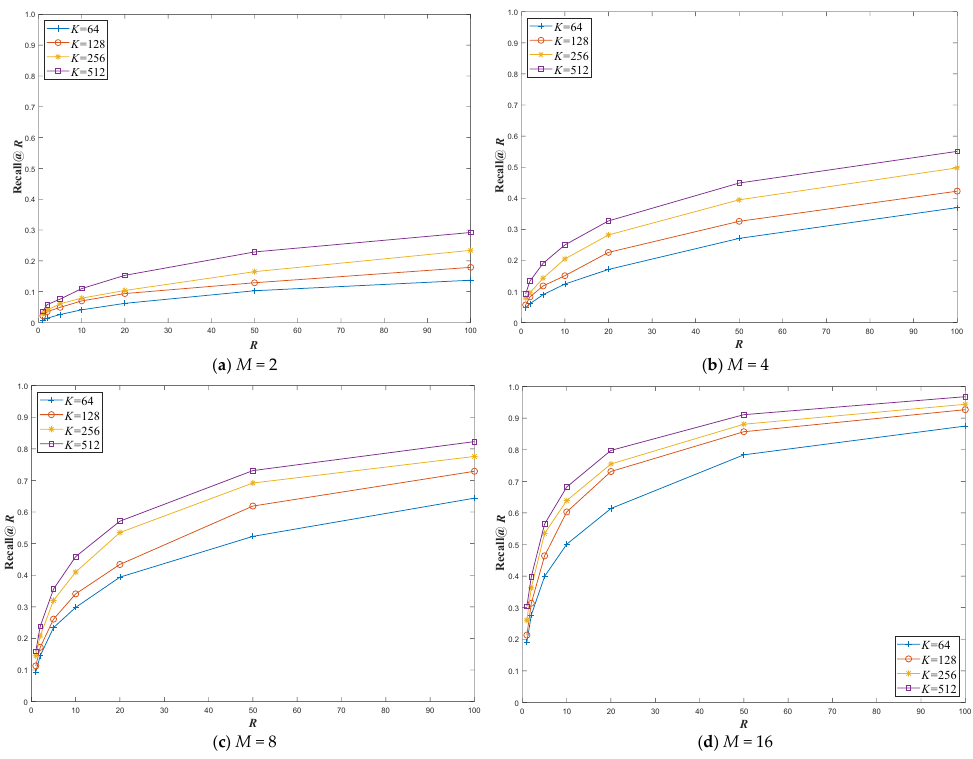
Figure 8. ANN Search accuracy under different K and M on GIST-1M. Figure 8. ANN search accuracies under different K and M on